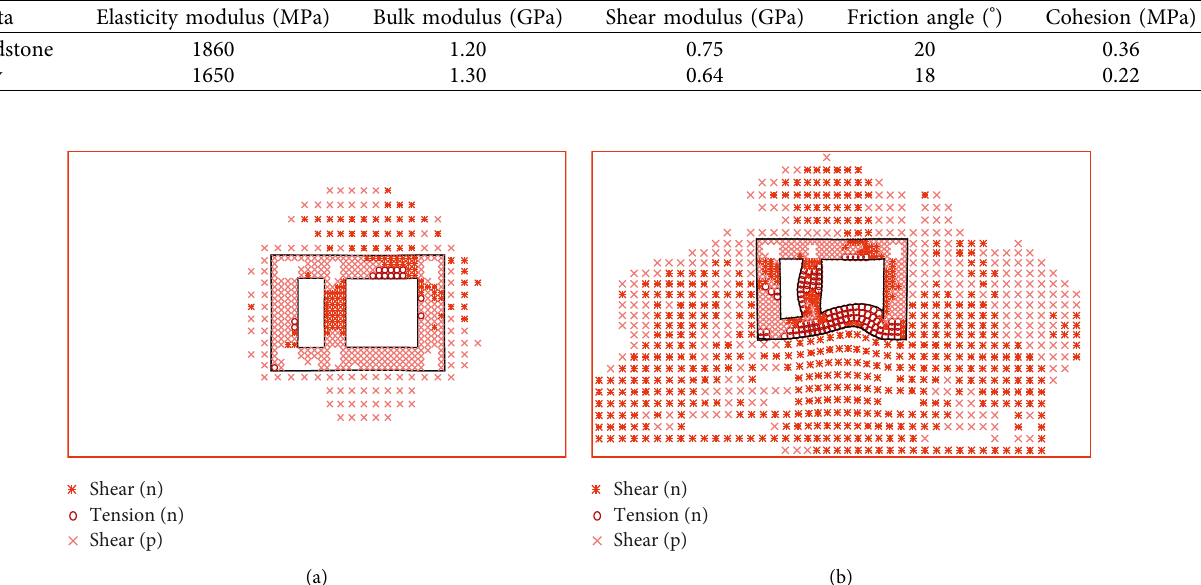
Table 2: Mechanical parameters of floor strata after immersed in water for 36h.